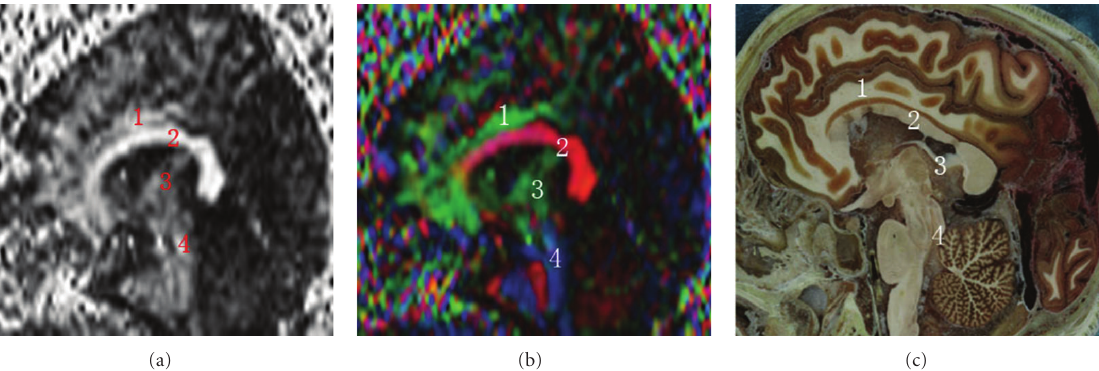
Figure 3: Sagittal FA map, color tensor map, and sectional image of visible human at the fornix. (1) Cingulate fasciculus, (2) corpus callosum, (3) fornix, and (4) superior cerebellar